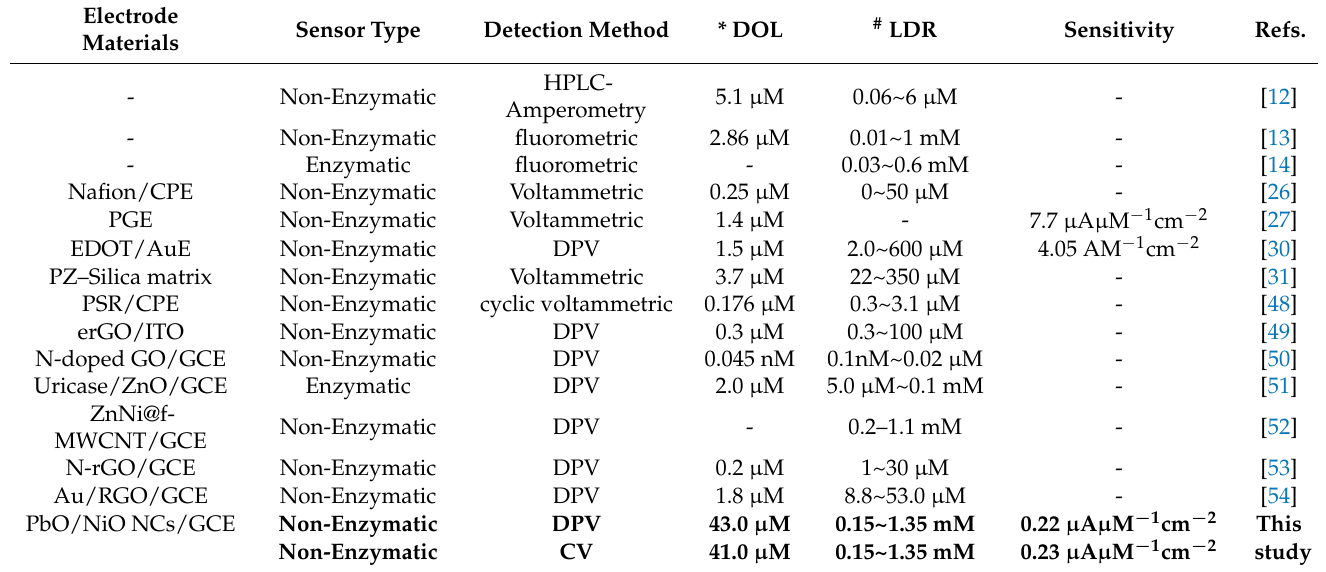
Table 1. Comparison of UA sensors based on various nanomaterial/nanocomposite materials by electrochemical approach. This study is bold.